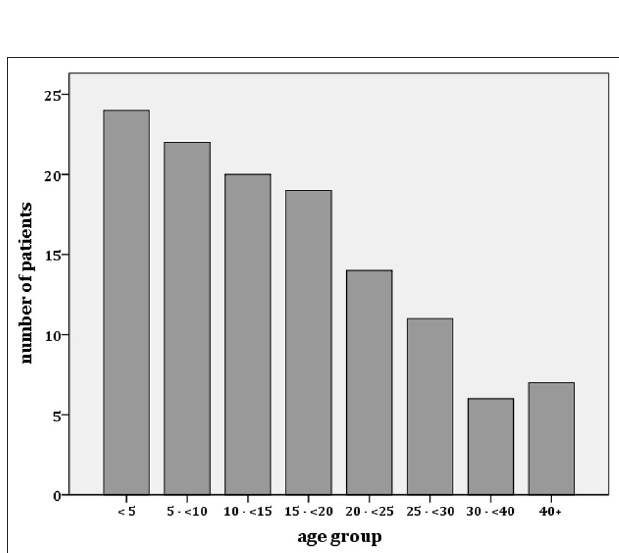
FIGURE 1 | Flow chart of study population, biopsy results and response to prednisone.